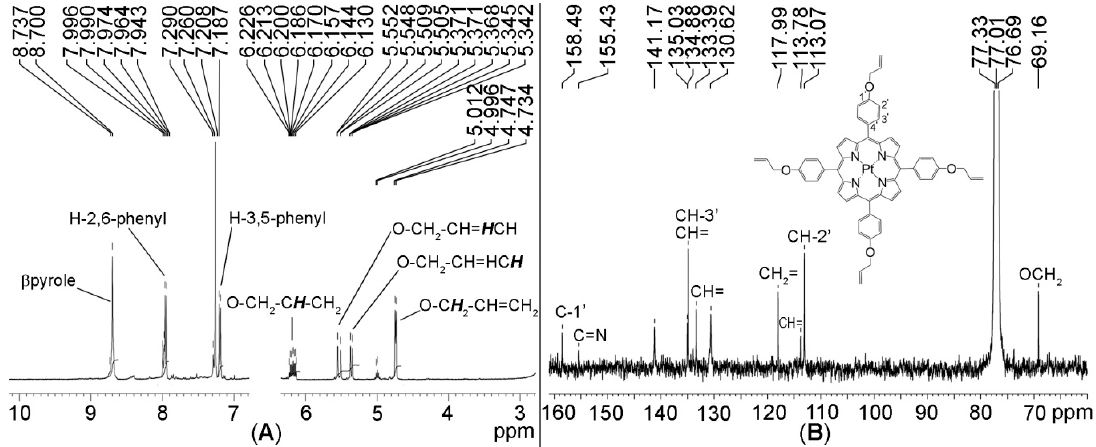
Figure 4. ( A ) 1 H-NMR spectrum and ( B ) 13 C-NMR spectrum of Pt(II)-TAPP in CDCl